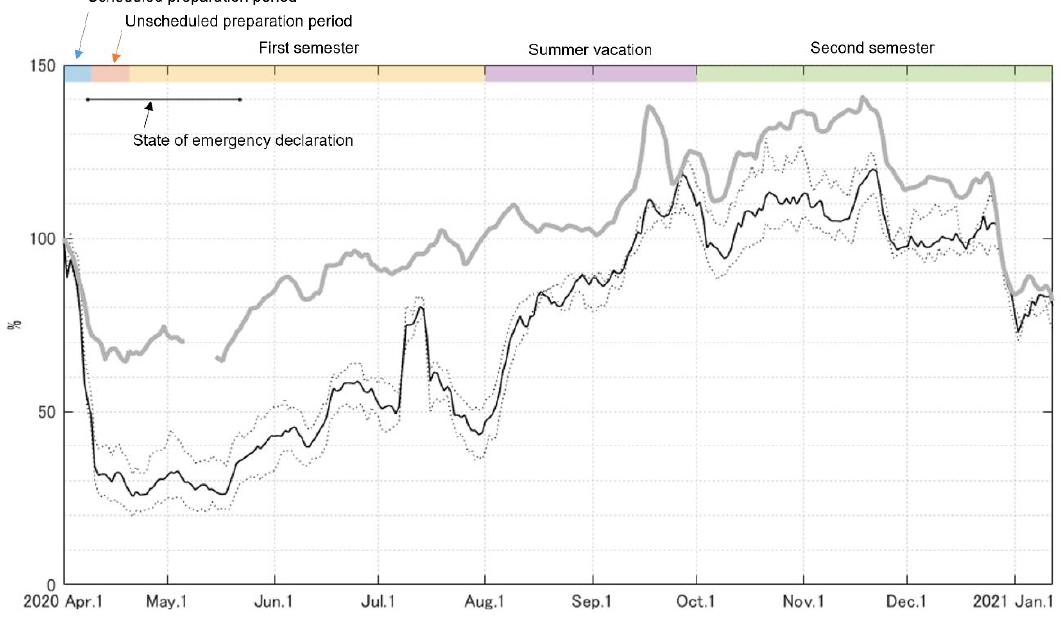
Figure 6. Apple Mobility Trend Reports with 7-day moving average (gray solid line) and median daily step counts with 7-day moving average (black solid line), both normalized by these data